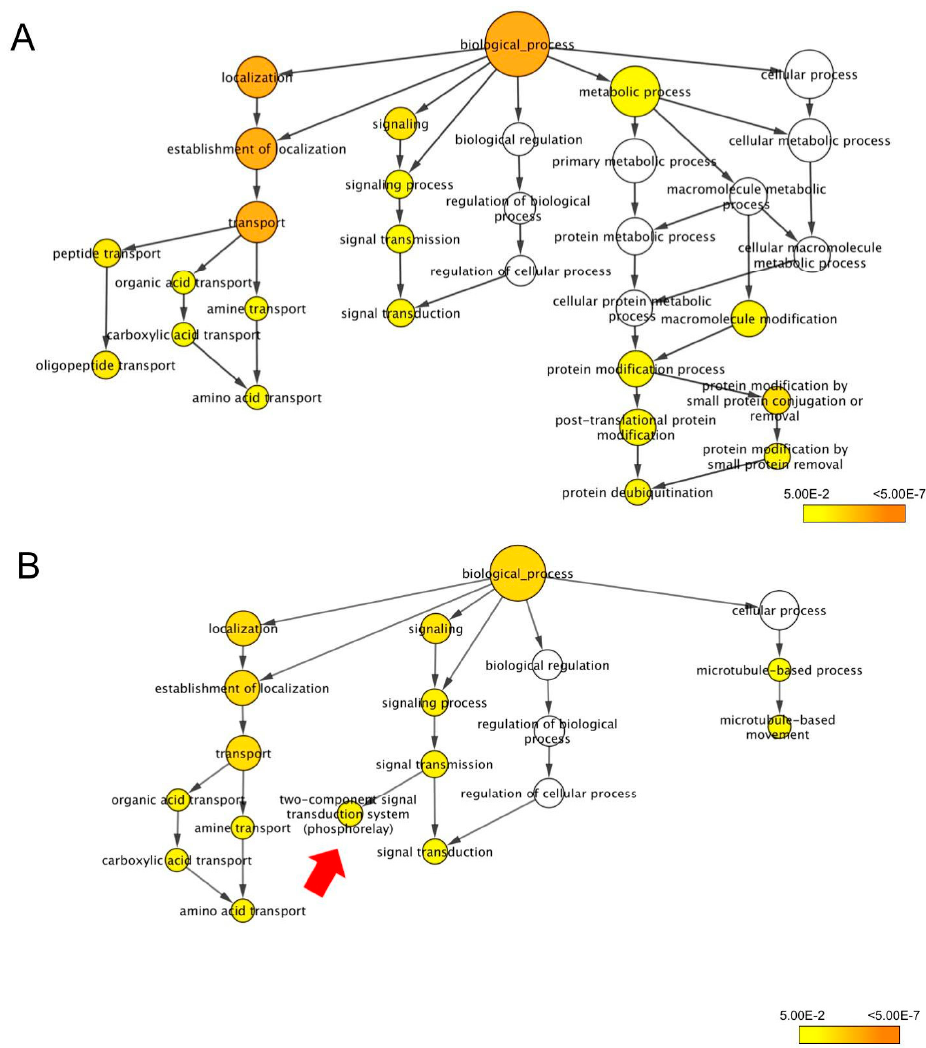
Figure 6. Biological process gene ontology (GO) terms enriched for the di ff erentially expressed genes (DEGs) in ‘KDML105’ ( A ) and CSSL18 ( B ) by BiNGO. The red arrow indicates a term enriched only for CSSL18